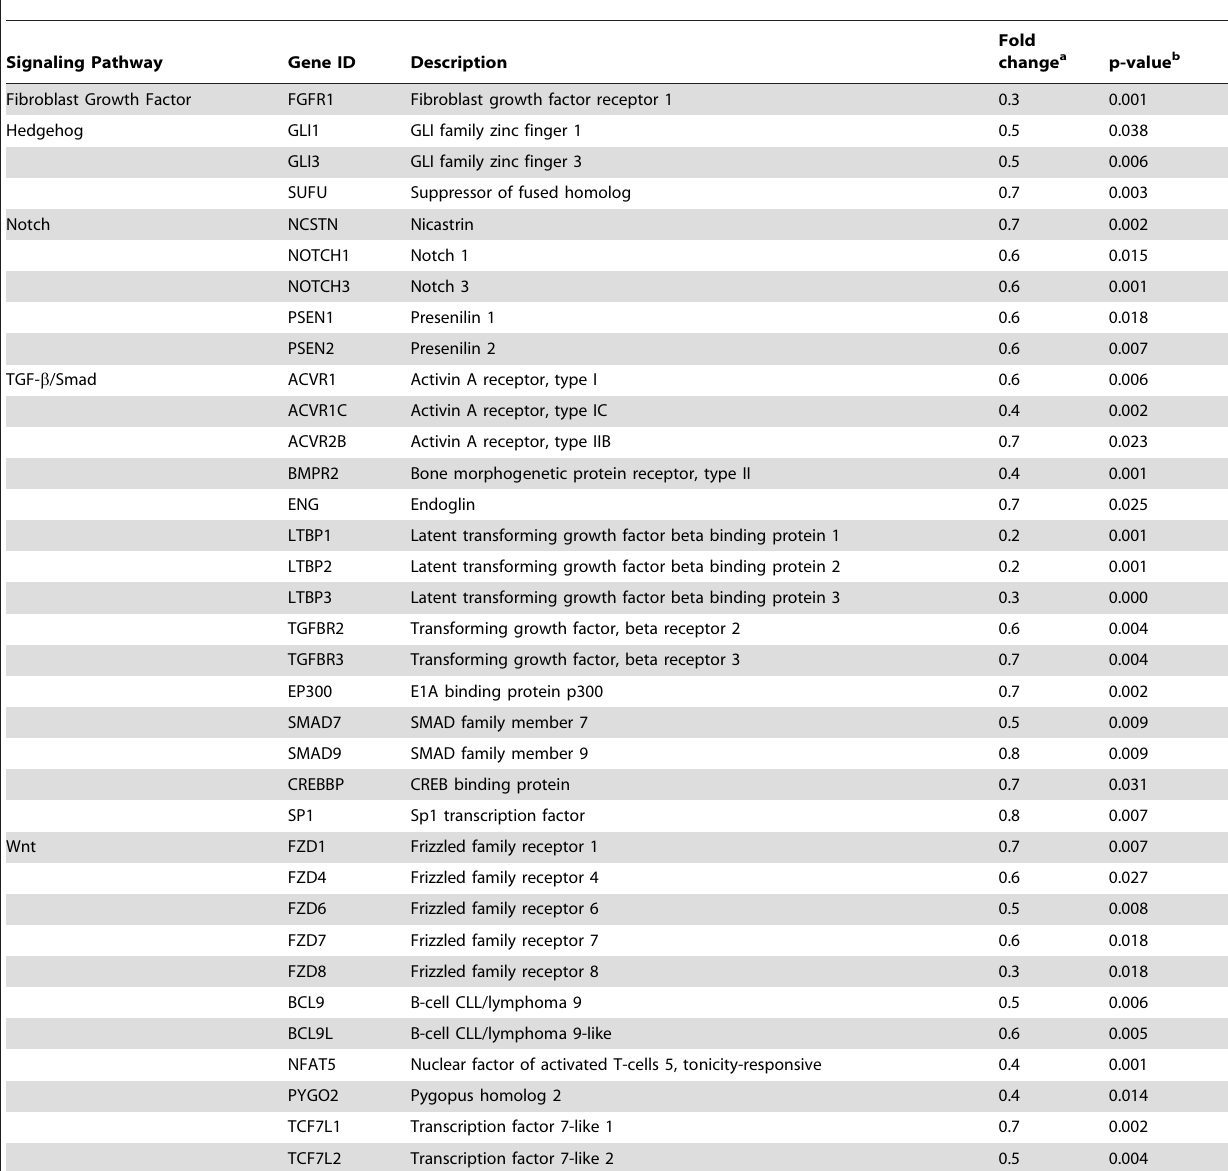
Table 1. Genes involved in stem cell signaling regulated by CDDO-Im in SUM159 tumorspheres.